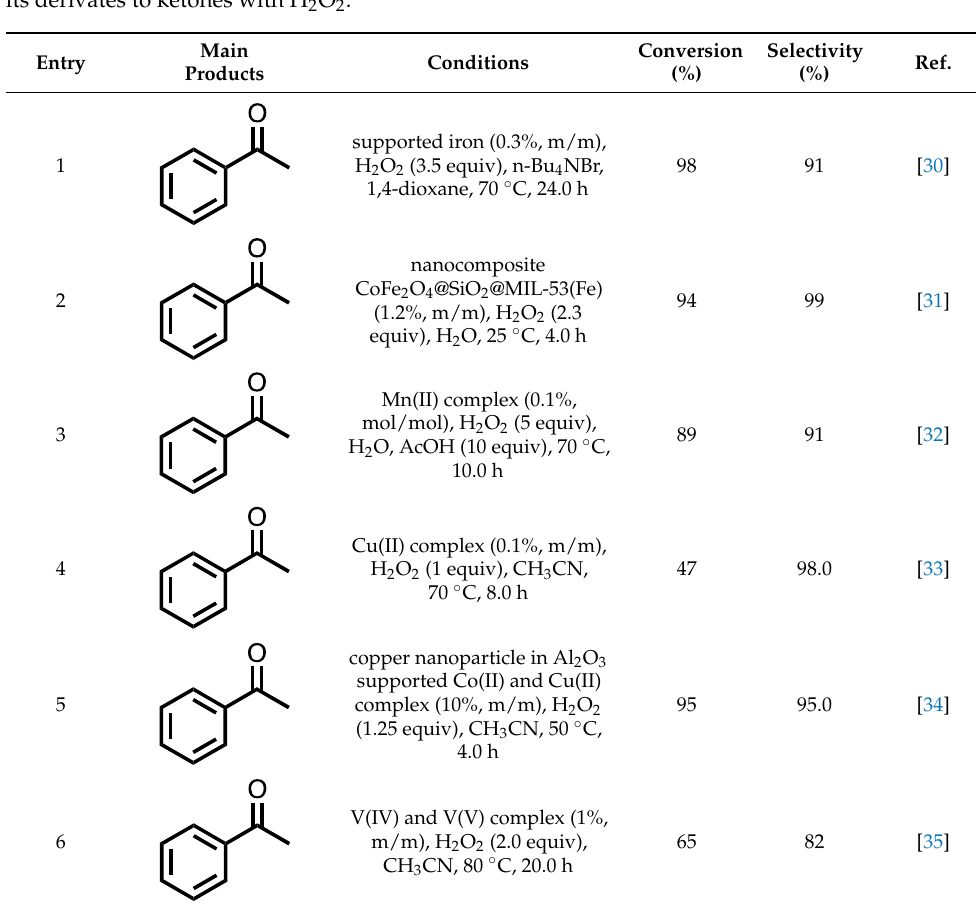
Table 8. Comparison with some reported systems for oxidative transformation of ethylbenzene and its derivates to ketones with H 2 O 2 .